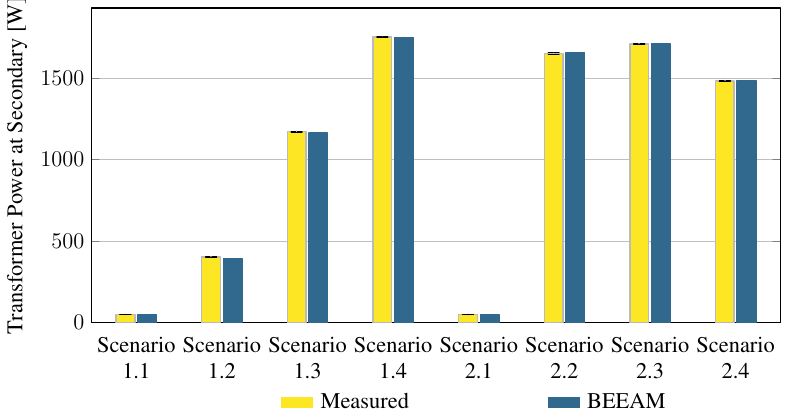
Figure A11. Predicted versus measured transformer power, secondary; Scenarios 1 and